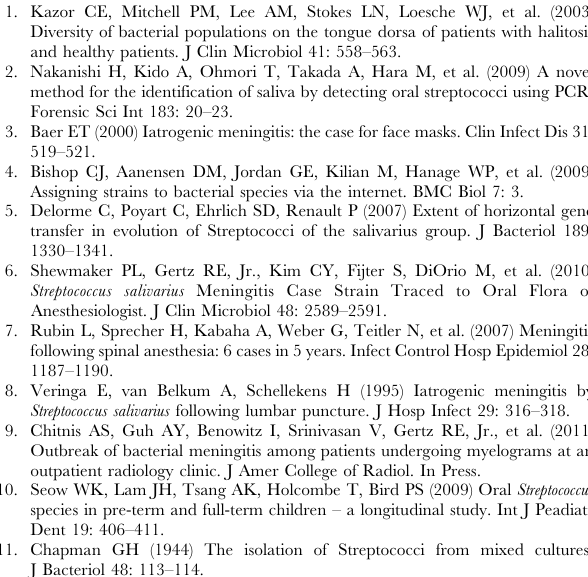
Table S1 Protocol for blood and body fluid DNA extraction optimized for streptococcal